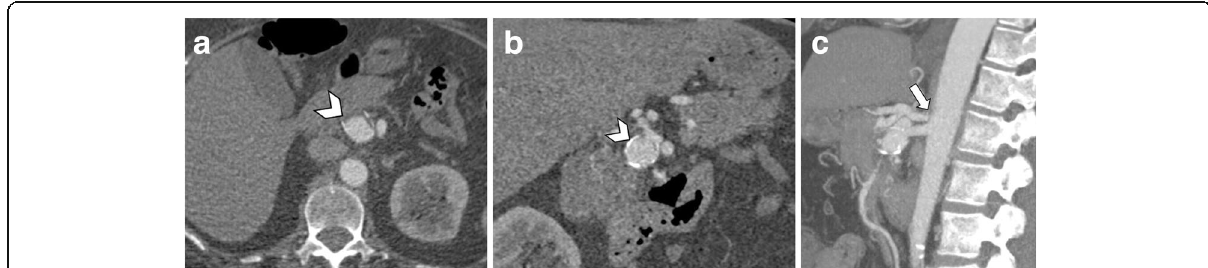
Fig. 3 A 63-year-old woman with median arcuate ligament compressing the celiac artery. Axial ( a ) and coronal ( b ) arterial phase CT image shows